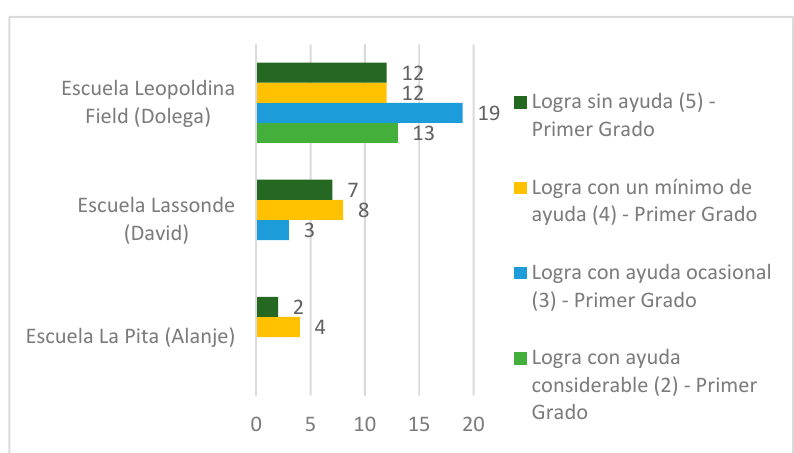
Figure 9. Valuation for the item build solutions.